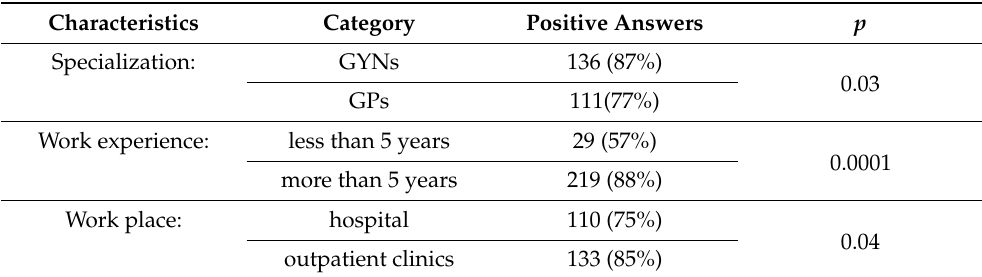
Table 2. Factors affecting the information provided by the doctor about HPV-related diseases and their prevention.